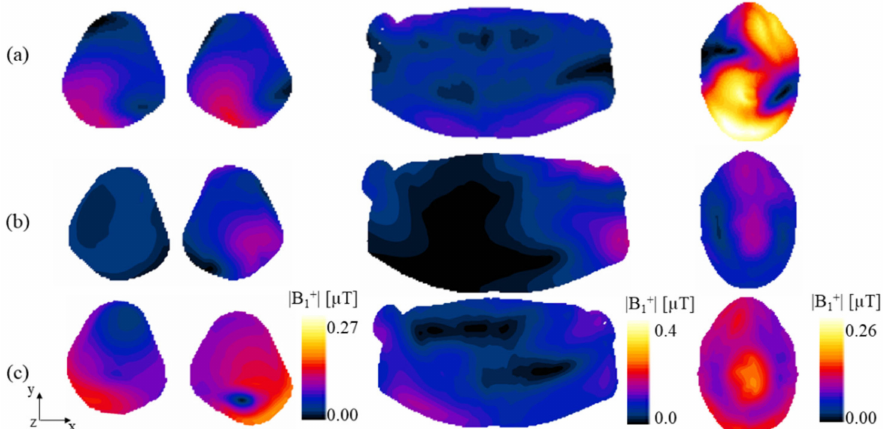
Figure 8. The axial view of the computed |B 1+ |-field for, ( a ) the path antenna, ( b ) birdcage coil, and ( c ) the array of t-MTL. The left column is an axial slice on the knee, middle on the torso, and right column is a slice inside the